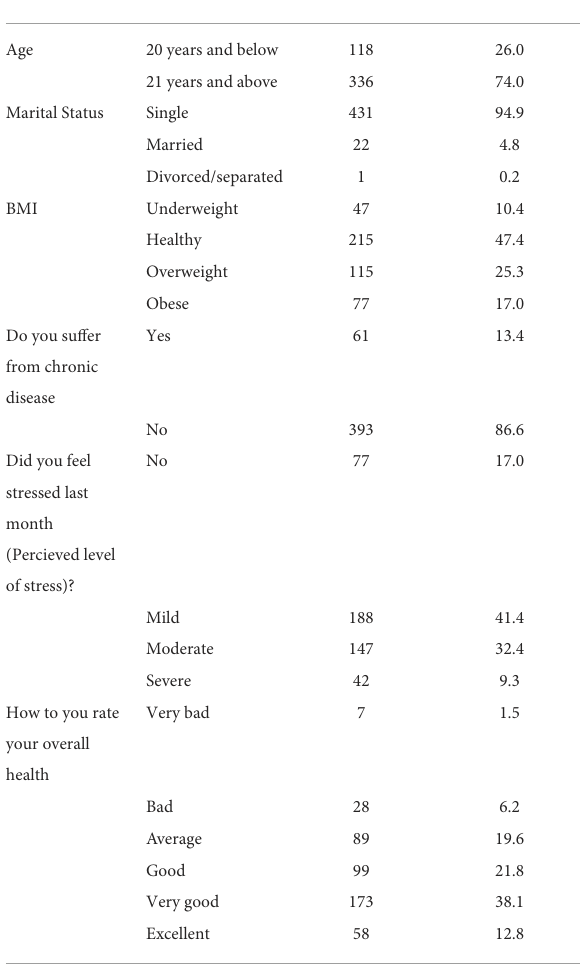
TABLE 1 Socio-demographic characteristics of the study participants ( n =